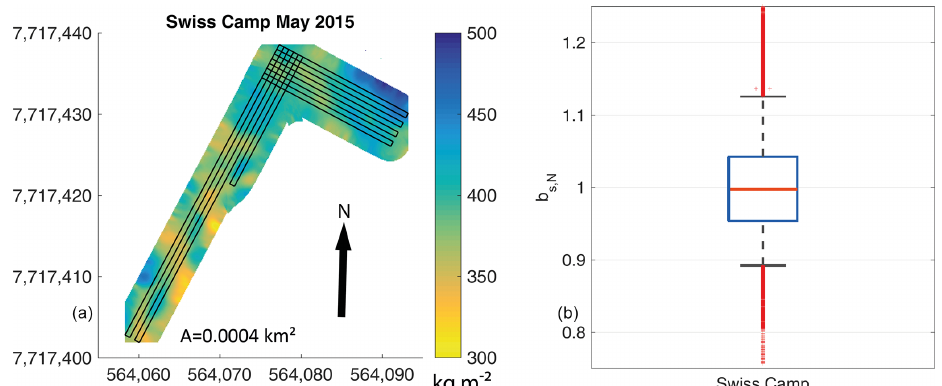
Figure 4. (a) Kriging results for the small radar transect at Swiss Camp for snow accumulation. The black lines display the recorded radar traces, and the black arrow indicates geographic north. A total area of 400m 2 can be covered by the applied spatial extrapolation. (b) Box plot displaying normalized data distribution ( b s , N ) of kriged output with the red horizontal line showing the median, the box framing the interquartile range, and the whiskers displaying the 5th and 95th percentiles. Outliers are shown as red crosses. The coordinates in (a) are given in UTM zone 22N with datum WGS 1984.